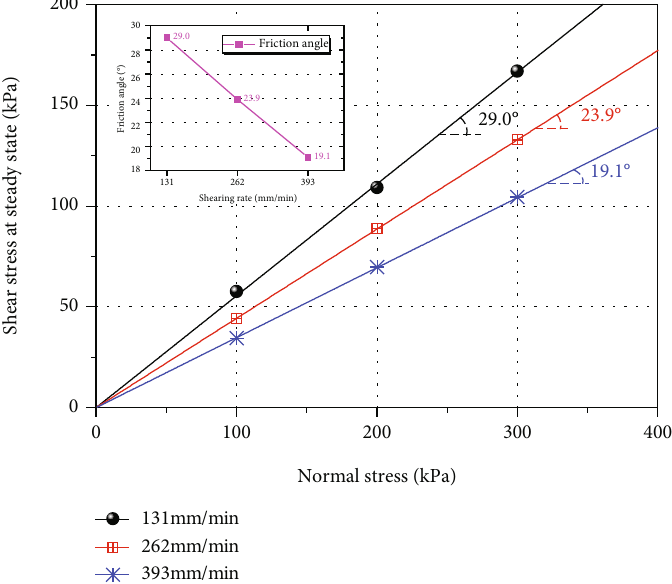
Figure 12: Relationship between friction angle and shearing